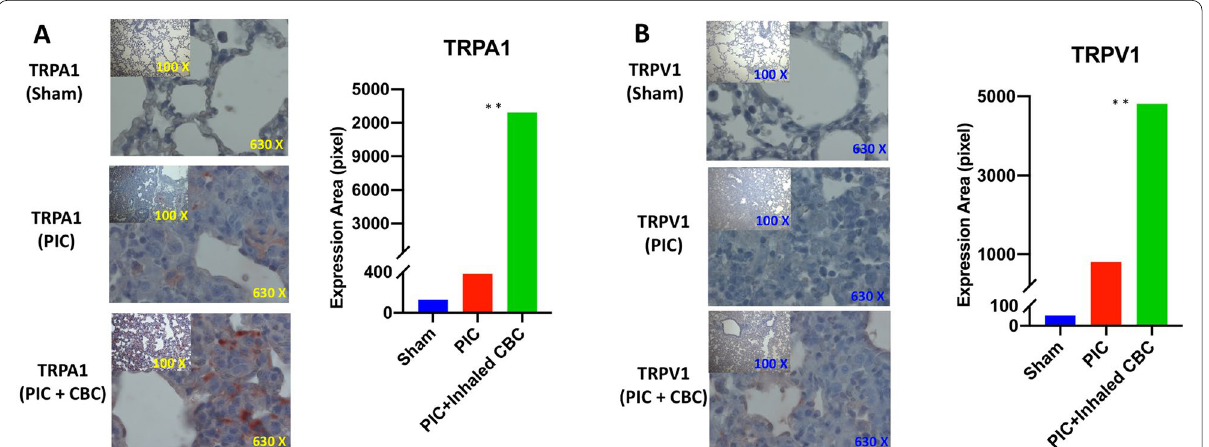
Fig. 2 Inhalant cannabichromene (CBC) may interact with the endocannabinoid system through enhancement of transient receptor potential (TRP) cation channels. Immunohistochemical staining of lung tissues with A transient receptor potential cation channel subfamily A member 1 (TRPA1) and B the transient receptor potential cation channel subfamily V member 1 (TRPV1) with less affinity showed an increase in the expression level of TRPA1 and TRPV1 in lung tissues of CBC treated group (PIC CBC) compared to normal sham or Poly (I:C) treated one (sham or PIC) (images + are all 630 and inner images are 100 magnification) (** p <0.01, means /-SD). The bar graphs demonstrate the quantified analysis of the staining × × + using particle count and color intensity measurement in the ImageJ software version